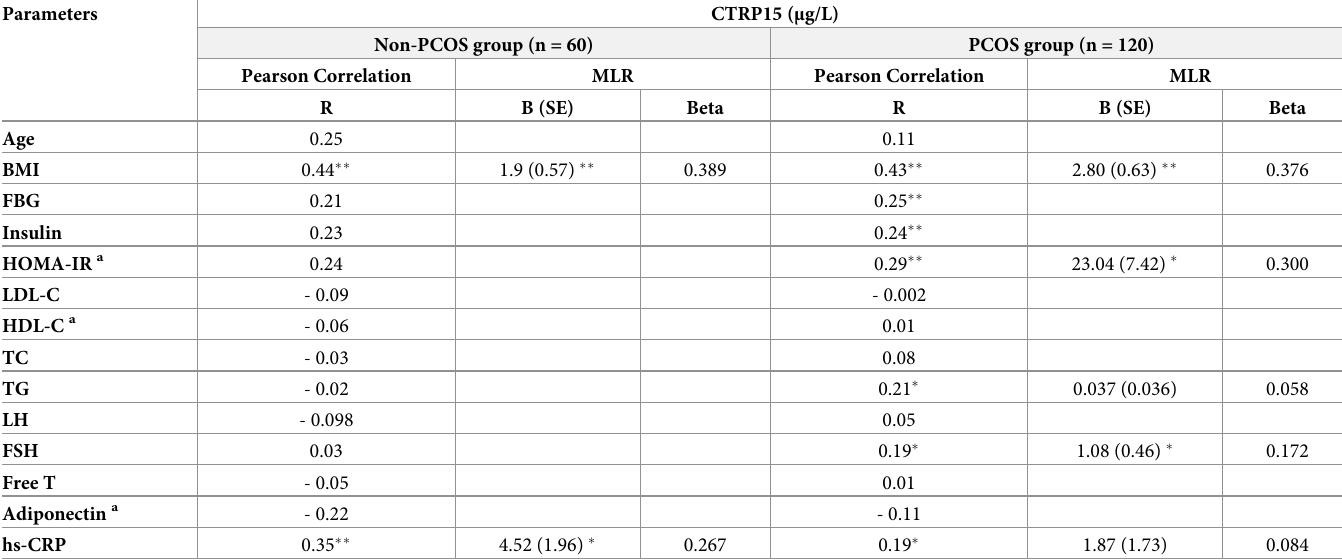
Table 3. Association between CTRP15 with the various clinical variables.